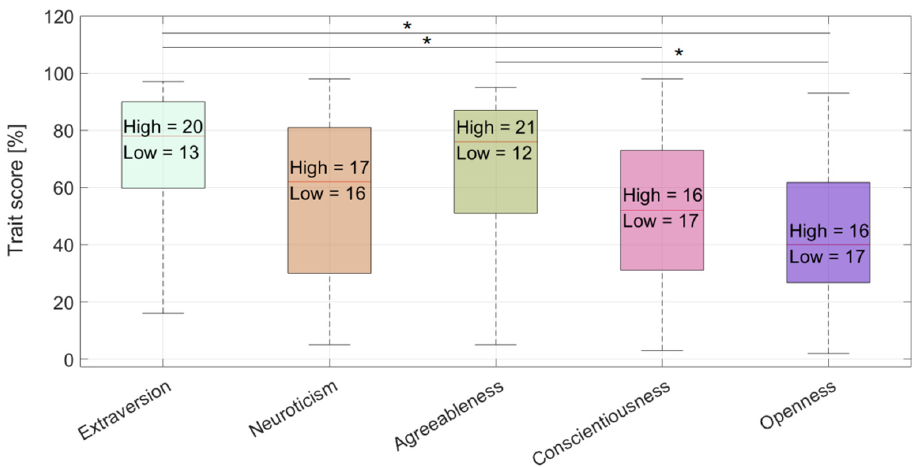
Figure 1. Whiskers and box plots of scores for each personality trait. The number of individuals with high and low personality traits. The central mark indicates the median, and the bottom and top edges of the box indicate the 25th and 75th percentiles, respectively. The whiskers extend to the most extreme data points; * marks statistically significant differences between factors ( p ≤ 0.05).